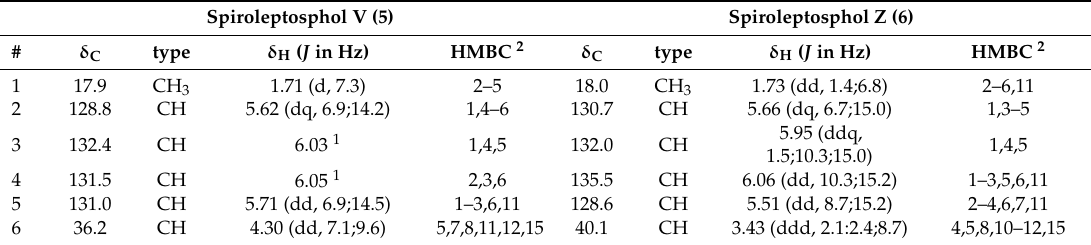
Table 2. NMR spectroscopic data (600 MHz, methanol-d4, 298.1 K) of spiroleptosphol V ( 5 ), Z ( 6 ), Y ( 7 ) and X ( 8